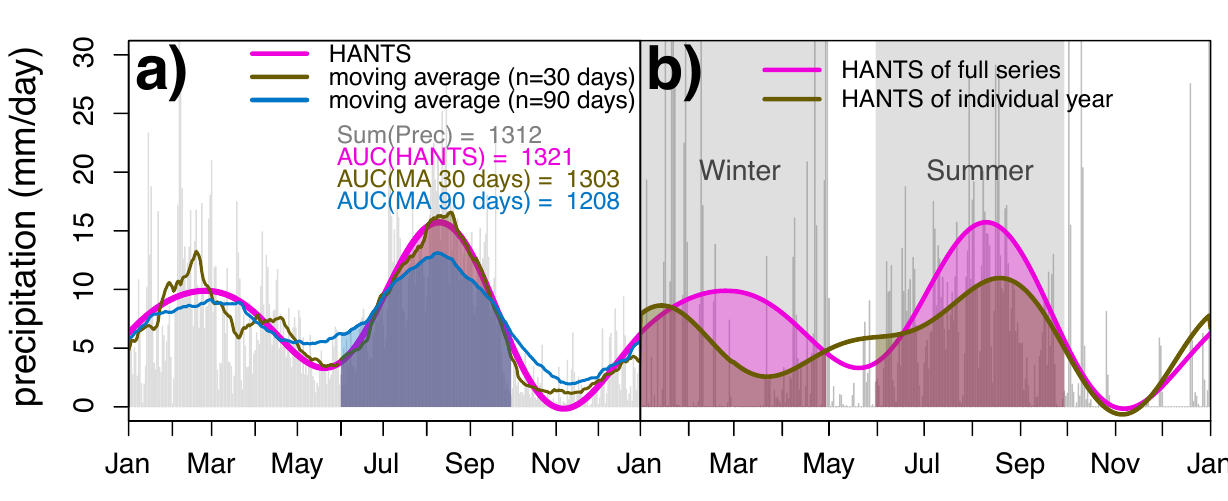
Figure 2. Harmonic time series analysis (HANTS) principals. ( a ) HANTS vs . running means with different window widths applied to a precipitation time series (grey) of a randomly-selected pixel; ( b ) HANTS is applied to find the maximum of the full time series and of individual years to determine the peak precipitation timing for each pixel (see Section 5). Anomalies are calculated as the difference of the area under the curve (AUC) of either the winter or summer season of an individual year and the full time series. Note that “HANTS of full series” is calculated based on the full length of the time series and shows the same shape in every year. “HANTS of individual year” is calculated individually for each year of the full time series, and thus, its curves show different shapes from year to year. Here, only one year is displayed for the sake of